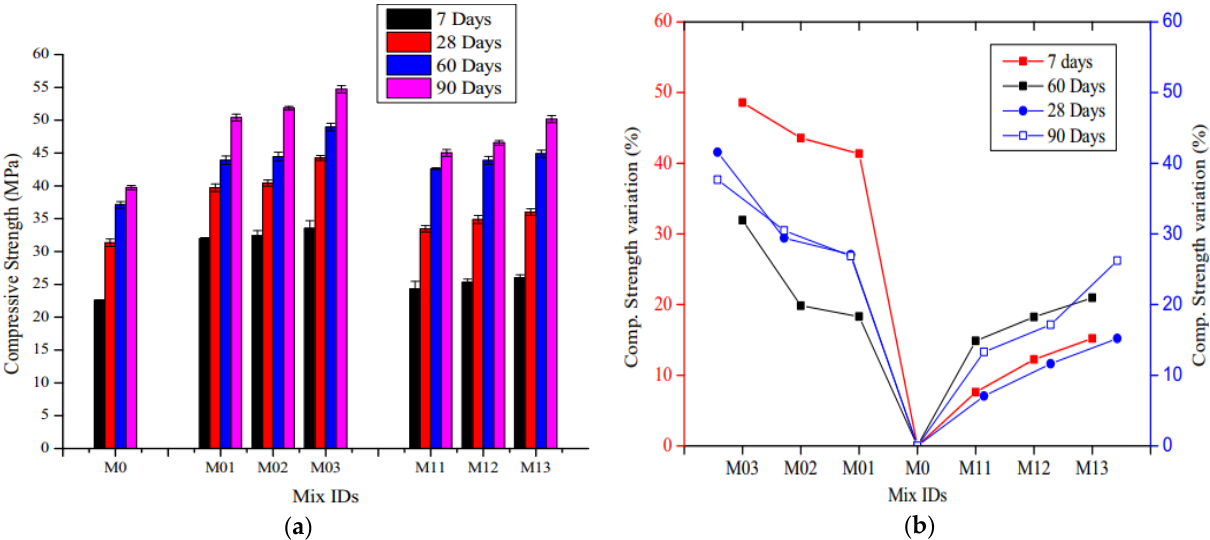
Figure 4. ( a ) CS at curing ages of 7, 28, 60 and 90 days; ( b ) percentage variation in CS at curing ages of 7, 28, 60 and 90 days [124]. The mixes M0, M01, M02 and M03 represent self-consolidating concretes with MSF contents of 0, 0.5, 1.0 and 1.5 %, respectively. The mixes M11, M12 and M13 represent self-consolidating concrete with WRSF contents of 0.5, 1.0 and 1.5 %, respectively.